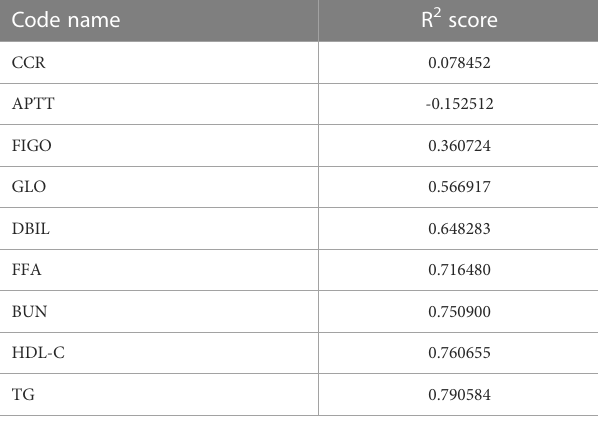
TABLE 3 Coef fi cients of different